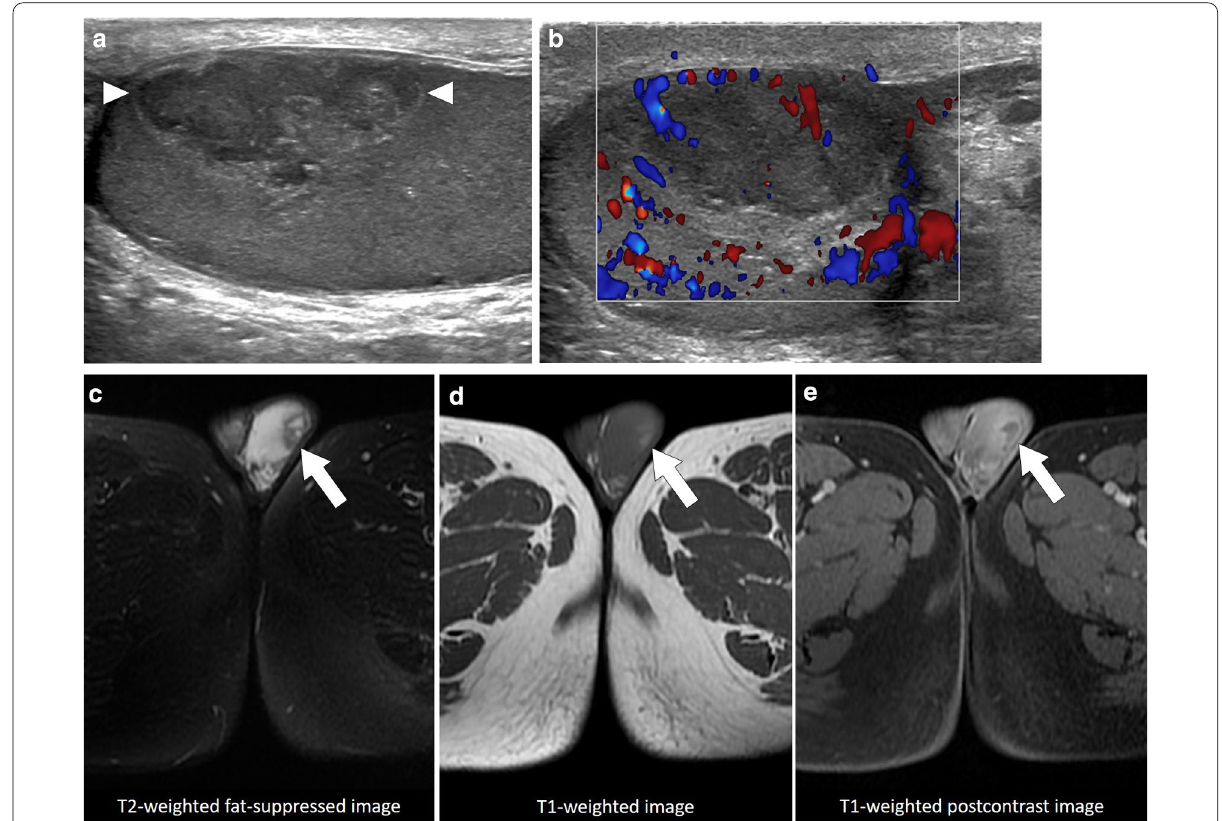
Fig. 15 Testicular hematoma. A 30-year-old male presenting after a fall from height for which he did not seek any medical care. Ten days after the initial event, he presented with a palpable left testicular mass. a Gray scale US shows a heterogeneous hypoechoic lesion in the left testis (arrowheads). b There was mild internal vascularity within this lesion on color Doppler US exam. Hematoma was considered as the initial diagnosis but as testicular tumor could not be ruled out an MRI order was placed. c‑d Axial plane T2W fat-suppressed and T1W images show high T1 and T2 signal intensities within the central part of the lesion (arrows) which was thought to represent hemorrhage in subacute phase. The peripheral low T2 signal intensity was considered hemosiderin deposition. e Axial plane postcontrast MR image shows no internal enhancement within the central part (arrow). During the follow-up, the lesion completely regressed, leaving mild testicular atrophy (not